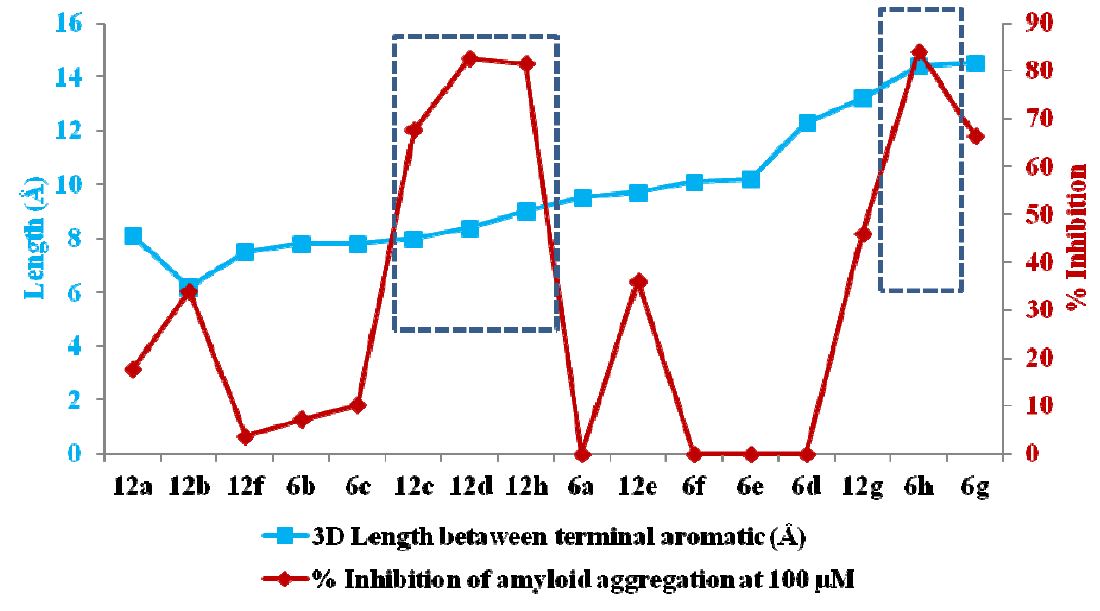
Figure 3. The relationship of bond length between aromatic terminal in the 3D structure and anti-amyloid aggregation